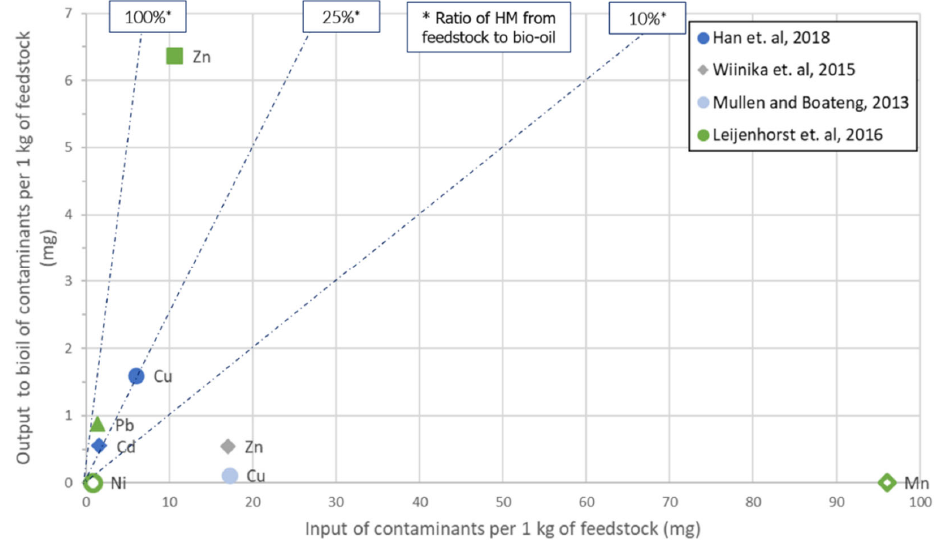
Figure 7. Pyrolysis: Output to bio ‐ oil vs. input with feedstock of HM species. Focus on low input loads. Adapted from